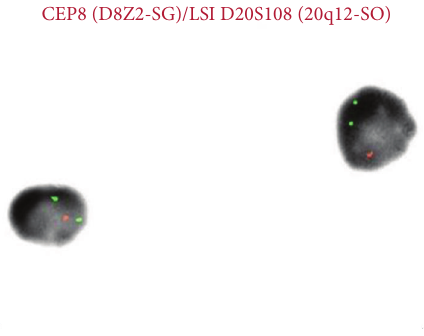
Figure 4: FISH MDS. Chromosomes 8 and 20 after 3 weeks of lenalidomide